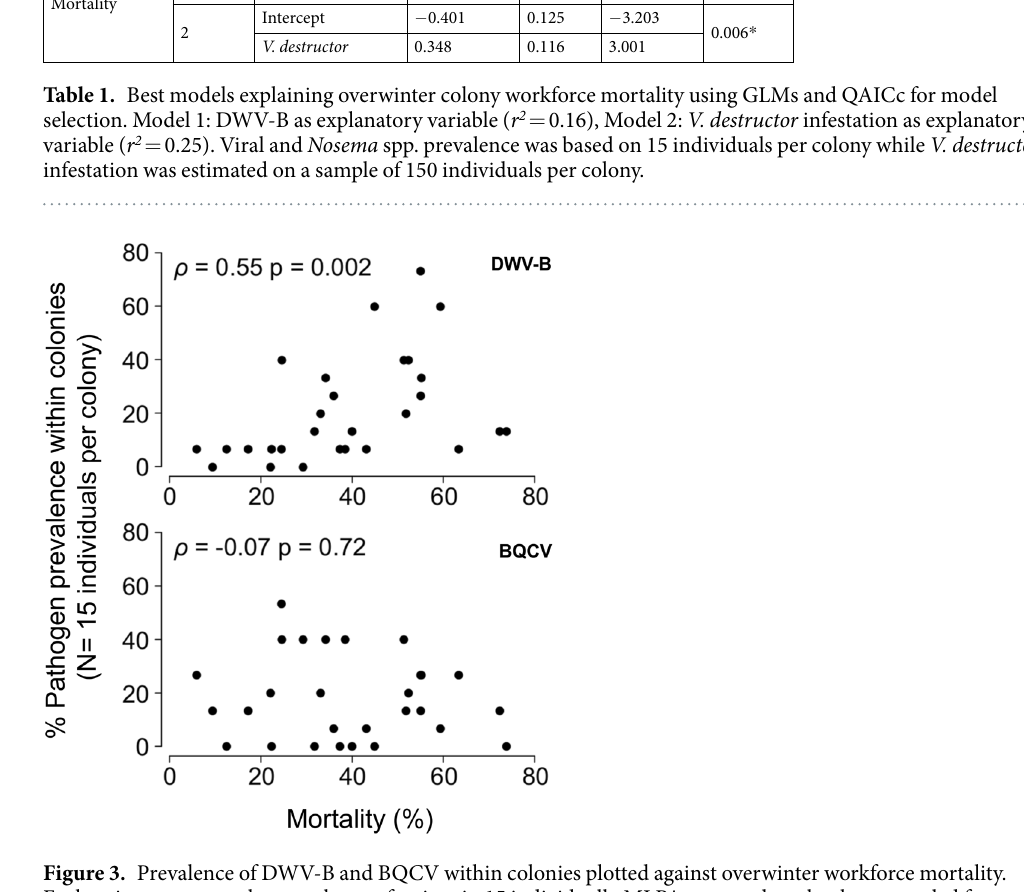
Figure 3. Prevalence of DWV-B and BQCV within colonies plotted against overwinter workforce mortality. Each point represents the prevalence of a virus in 15 individually MLPA-screened worker bees sampled from each colony in autumn. Spearman’s ρ and significance levels are shown for